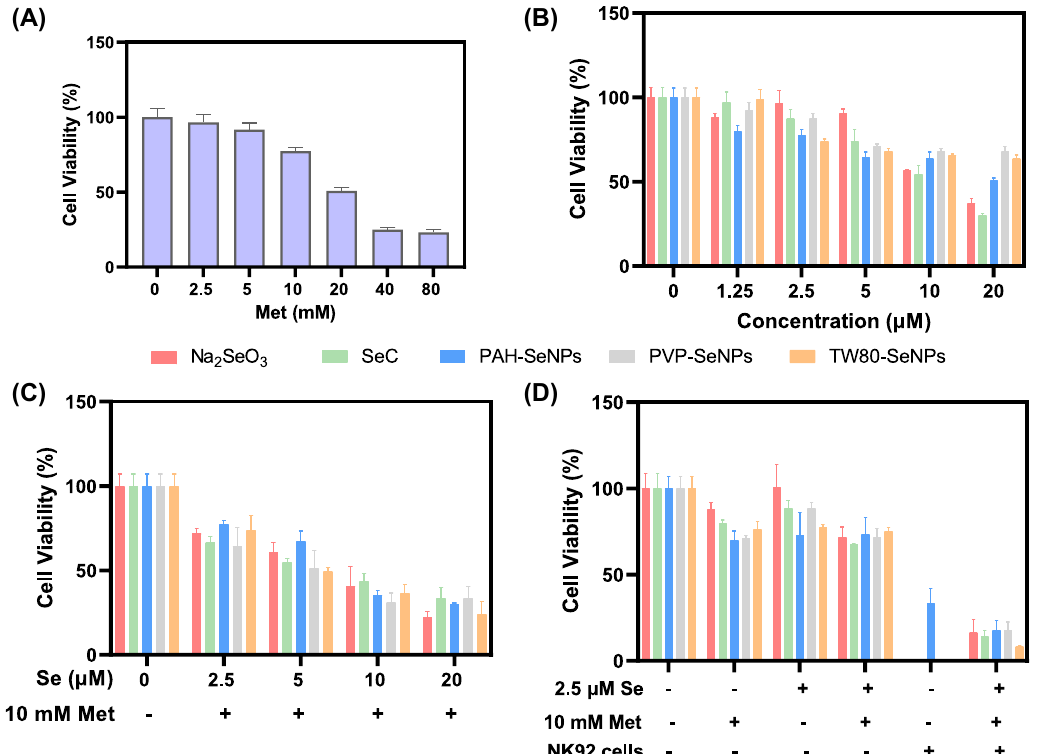
Figure 4: The cell viability of different SeNPs combined with met and NK92 cells in MG63 cells. The cell viability of (A) met, (B) different SeNPs, and (C) SeNPs combined with met in MG63 cells for 48 h. (D) The cell viability of different SeNPs combined with met for pretreatment 24 h and then NK92 cells co-treatment for 24 h in MG63 cells. Each value represents as means ± SD ( n =